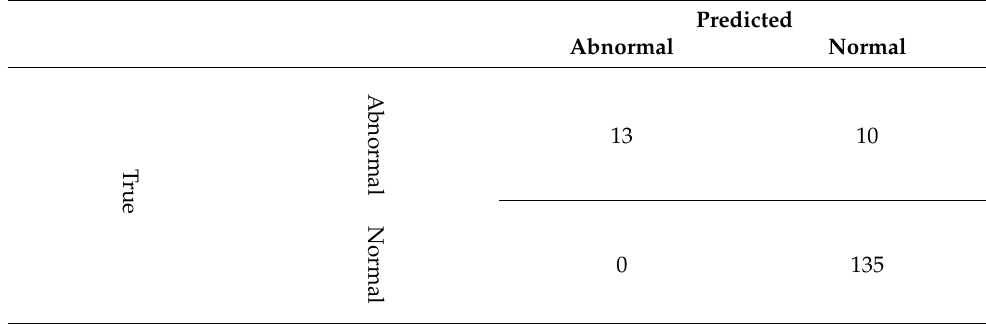
Table 5. Confusion matrix of the model in which the number of mixture components K was 64 (the threshold is the 100th percentile’s